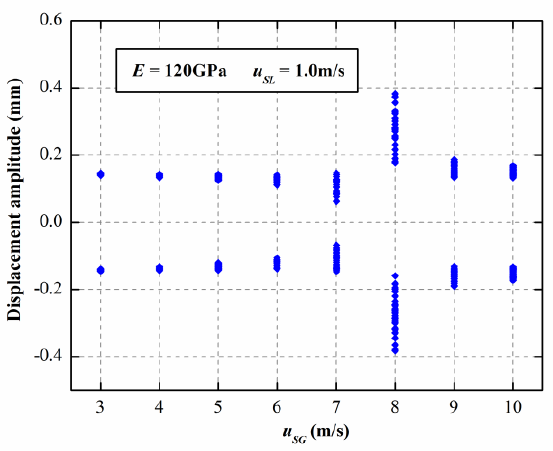
Figure 8. Bifurcation diagram for the midpoint of the piping system for E = 120 GPa.